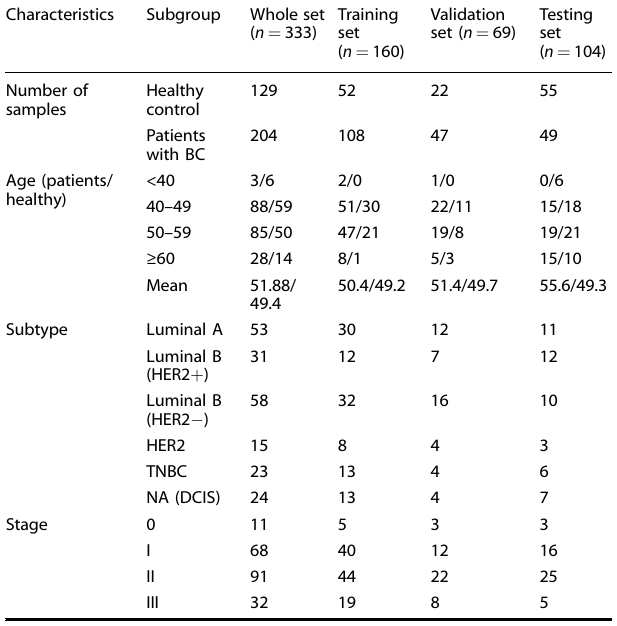
Table 1. Characteristics of healthy volunteers and patients with breast